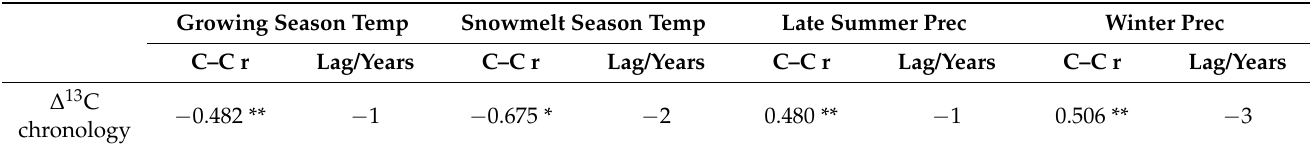
Table 4. Cross-correlation between ∆ 13 C chronology and climatic factors (temperature and precipitation) and lags be- tween